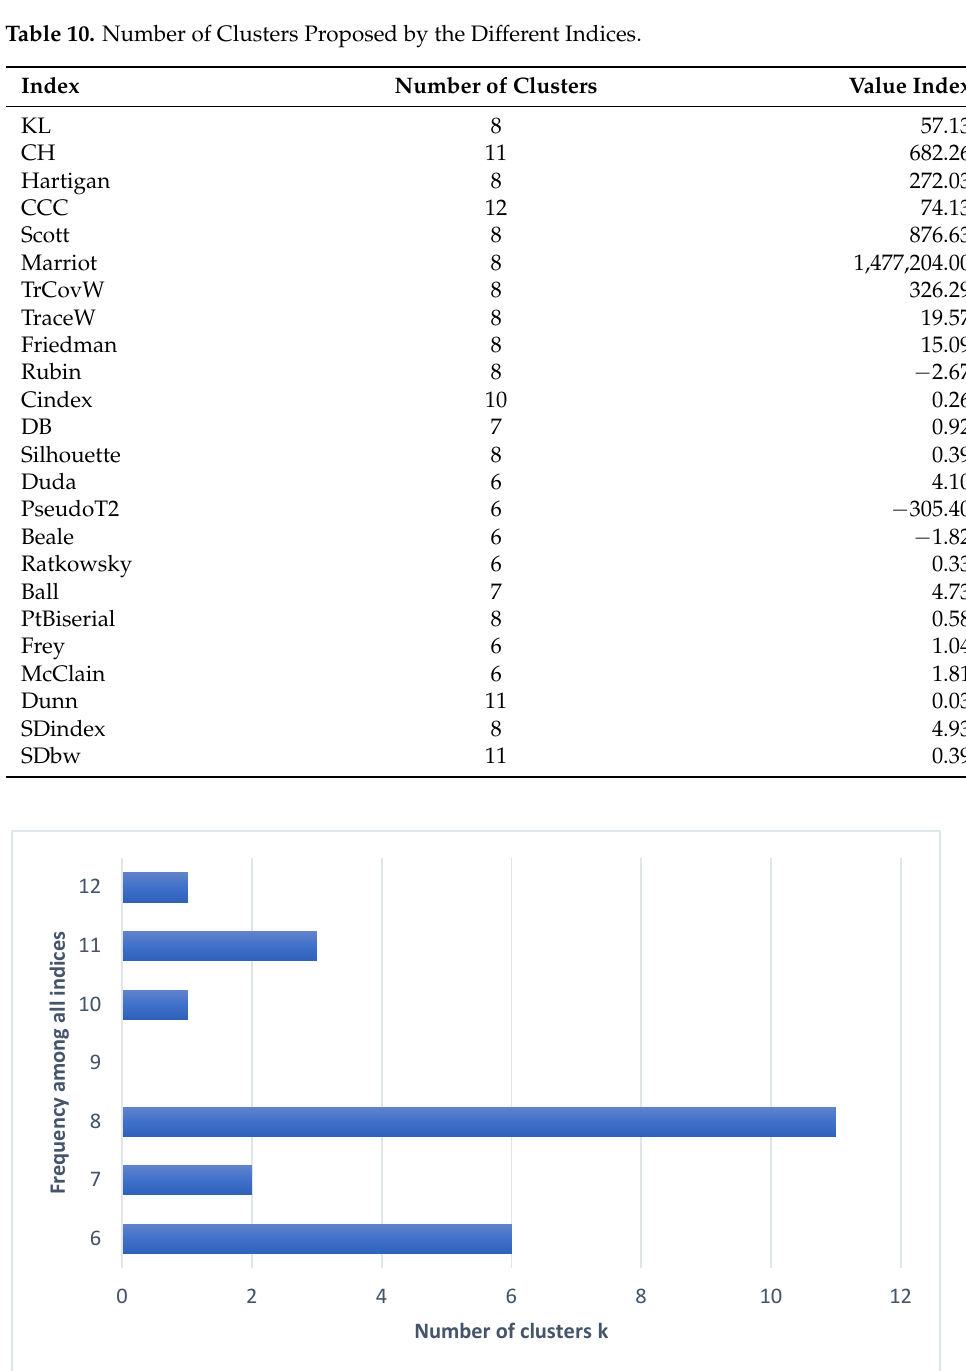
Table 11. Result of the k-Means Algorithm.